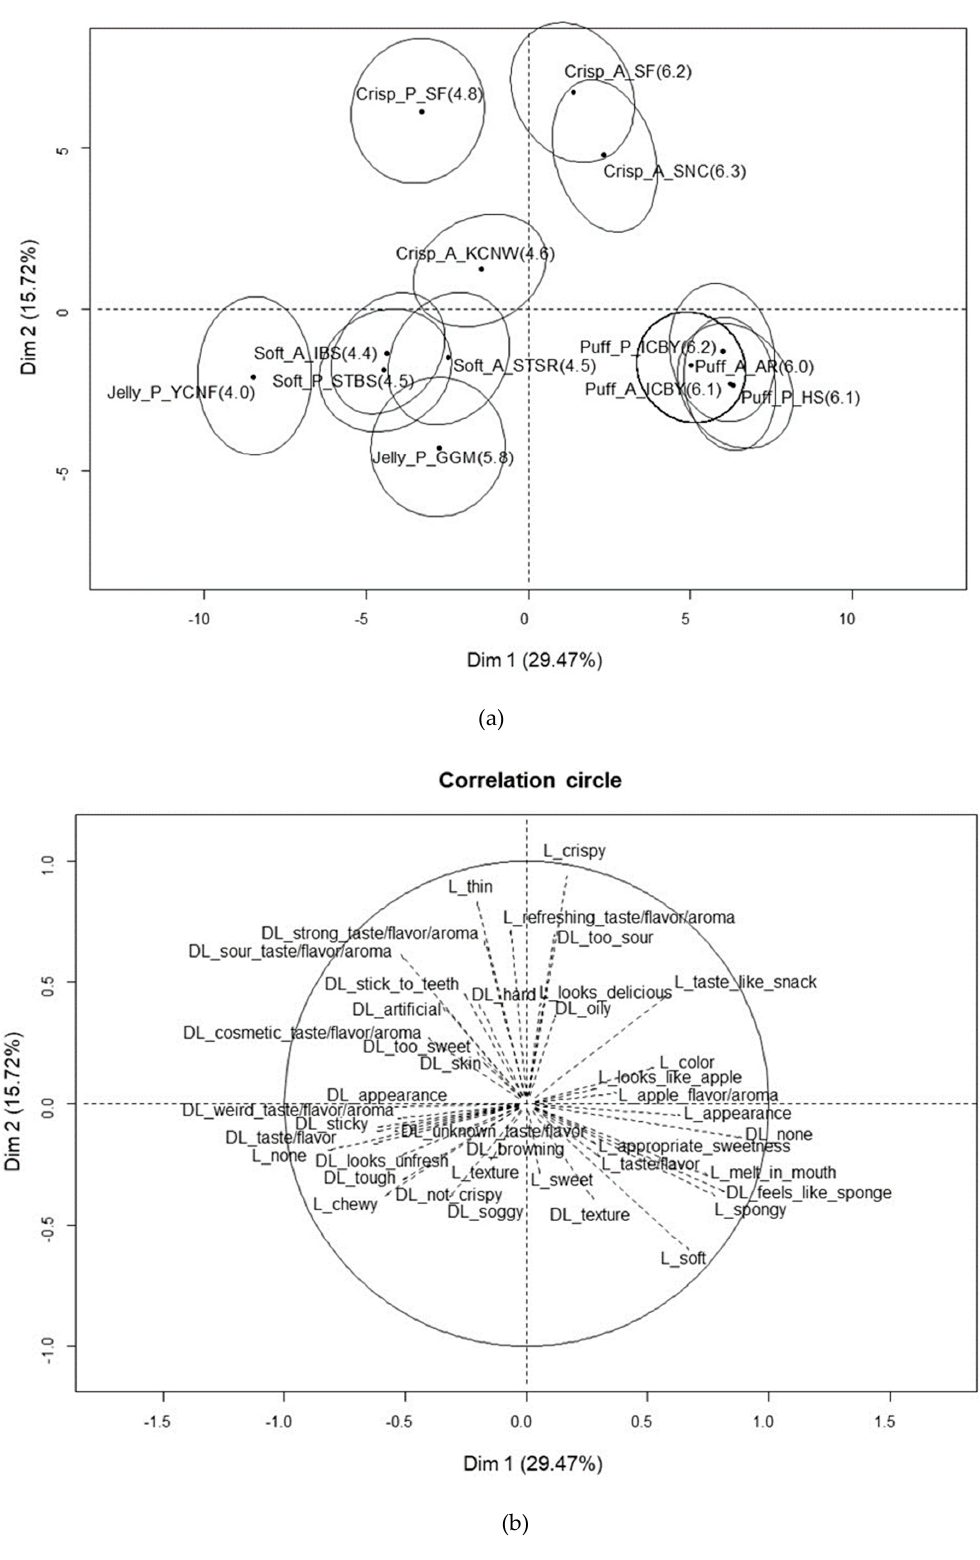
Figure 3. MFA plot of 13 dried fruit chips ( a ) and the reasons for liking and disliking them ( b ) among Korean consumers.